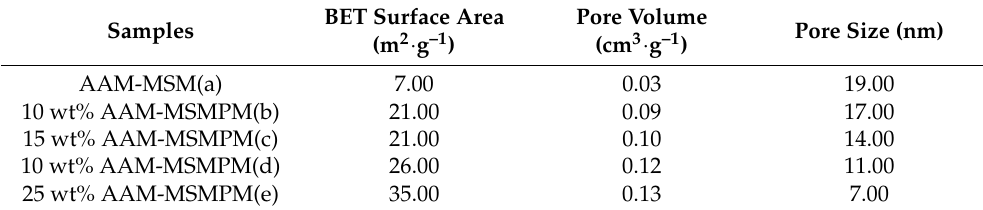
Figure 5. N 2 -adsorption – desorption isotherms ( A ) and pore distribution profiles ( B ) of the AAM-MSMPM ( a , without porogen), ( b , 10 wt% porogen), ( c , 15 wt% porogen), ( d , 20 wt% porogen), ( e , 25 wt% porogen). Table 2. Texture properties of the AAM-MSM and AAM-MSMPM adsorbents.